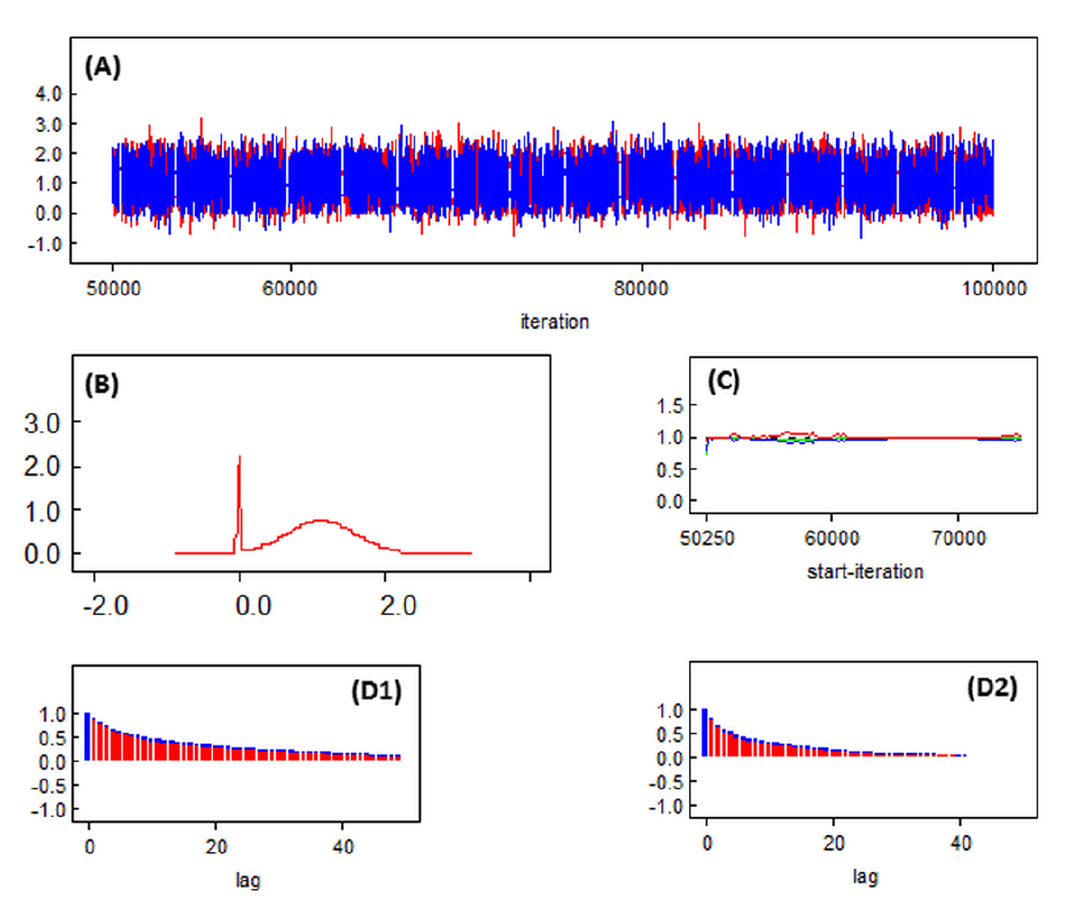
Figure 2. Diagnostic plots: trace plot ( A ); posterior density plot ( B ); Brooks-Gelman-Rubin (BGR) statistic plot ( C ); and autocorrelation plots in the absence of thinning ( D1 ) and for thinning = 2 ( D2 )—for cord blood imputed dataset 1 CpG site